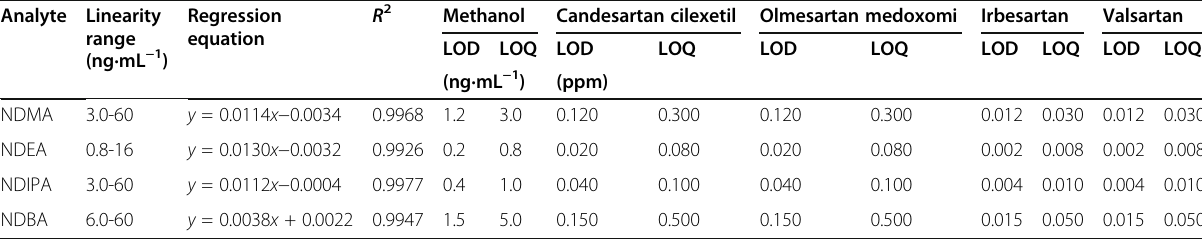
Table 4 Calibration curves, LODs, and LOQs for four N-nitrosamines Analyte Linearity range (ng·mL − 1